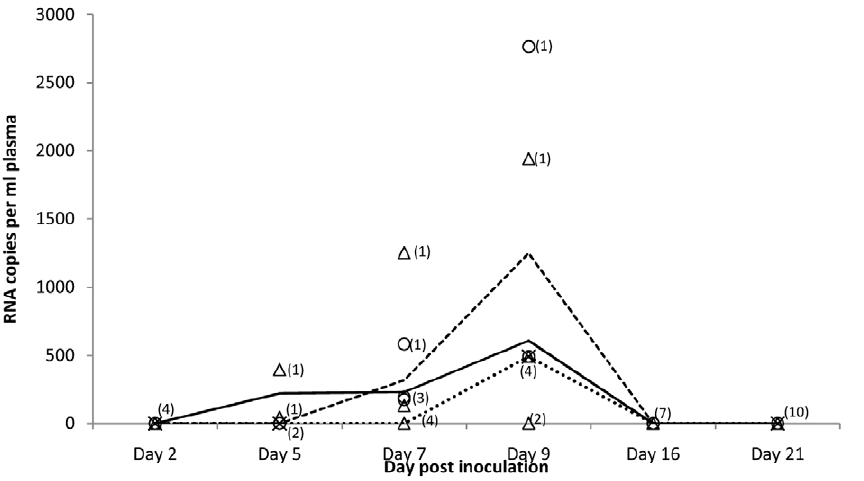
Figure 4. Viremia levels in R.aegyptiacus inoculated by intraperitoneal and subcutaneous route with MARV isolate MHK. MARV RNA copies per ml of plasma in individual adult females ( D ), adult males ( # ) and pups (x), and mean copy numbers for females (------), males (---) and pups NNN ) are shown. (